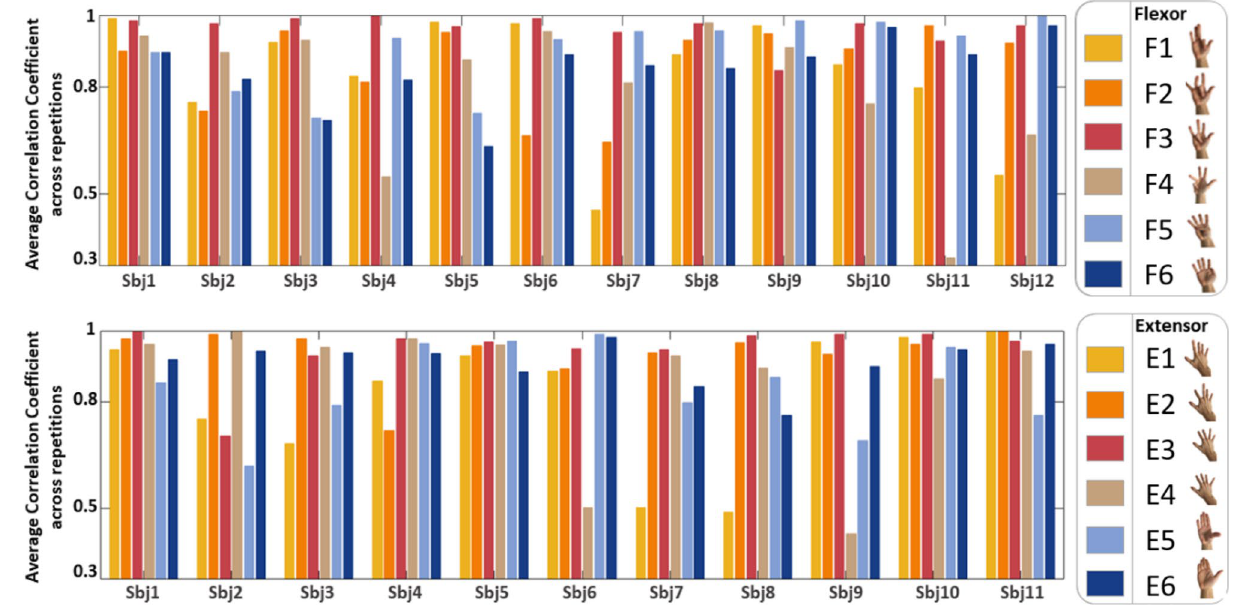
Figure 2. Intra-subject similarity analysis for the flexion (F) and extension (E) tasks. The similarity coefficient (averaged across repetitions) is shown for all the gestures (color code), and subjects, for the flexion (upper panel) and extension (lower panel) sessions, separately. Note that the y-axis ranges from 0.3 to 1. Figure created with Matlab 2020a.